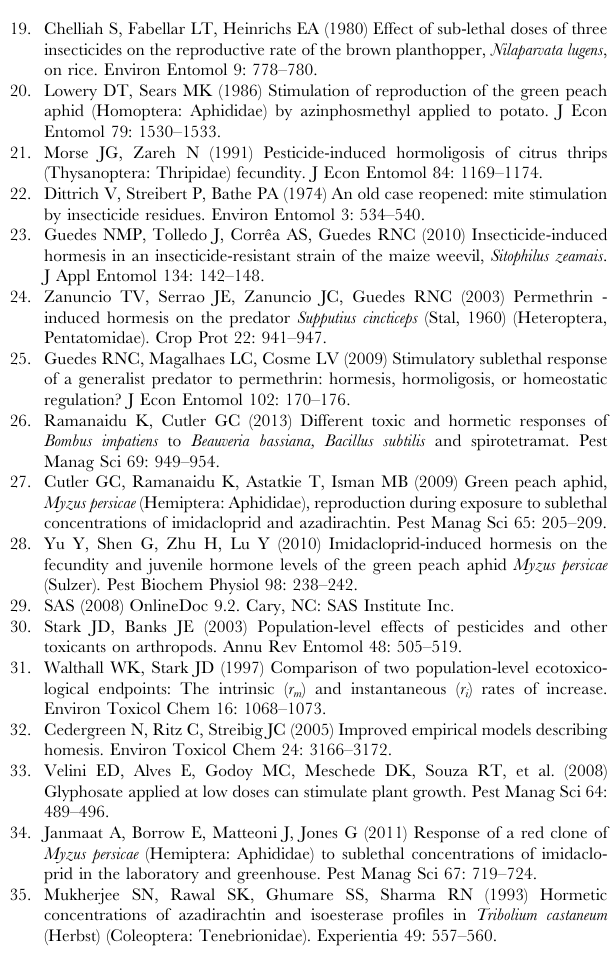
Figure 2. Hormesis model-fitting of low doses of imidacloprid on fecundity and r i of aphids. Four-parameter biphasic model [32] for reproductive hormetic responses of M. persicae in an initial (A) and second (B) generation when continuously exposed to sublethal concentrations of imidacloprid on potato leaf discs, and (C) the instantaneous rate of increase ( r i ) of M. persicae populations developing on whole potato plants treated with sublethal concentrations of imidacloprid. * indicates data were square-root transformed before